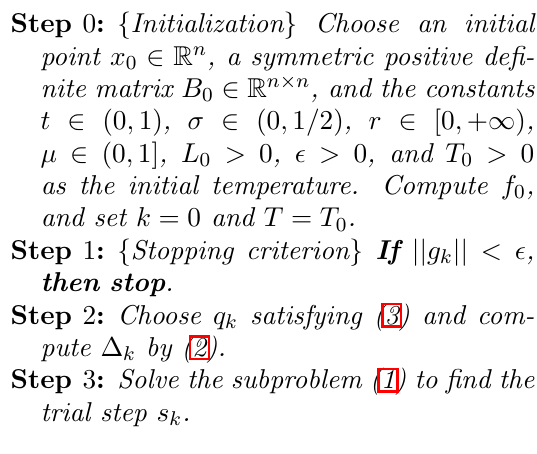
Algorithm 2.1. (A randomized trust region line search algorithm